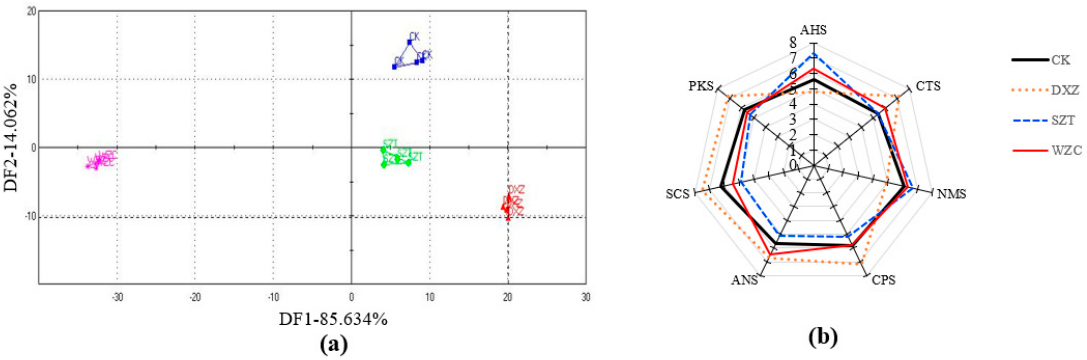
Figure 2. Results obtained by using the electronic tongue. ( a ) Discriminant factor analysis (DFA) diagram of the electronic tongue data for the control (CK; blue), triadimefon-treated (SZT; green), tebuconazole-treated (WZC; pink), and paclobutrazol-treated (DXZ; red) wine groups. ( b ) Radar image of the taste characteristics of the triazole-pesticide-treated wine samples.